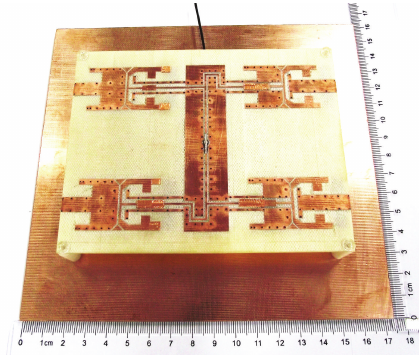
Figure 7: Fabricated antenna with additional ground.